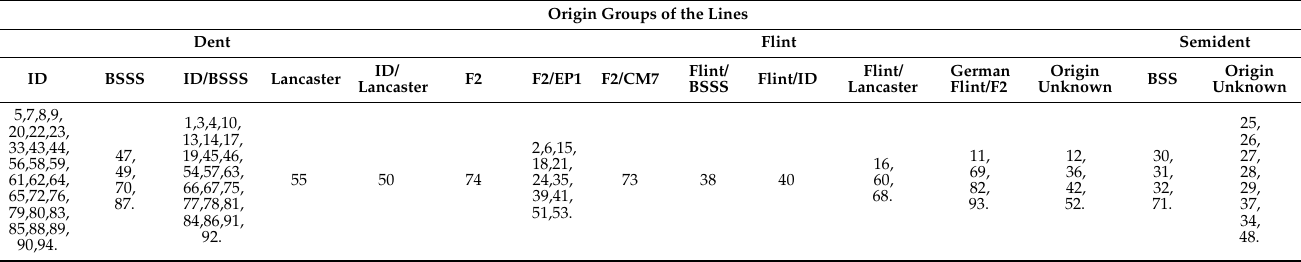
Table 2. Division of plant material into groups of origin (line numbers from 1 to 94). Origin Groups of the